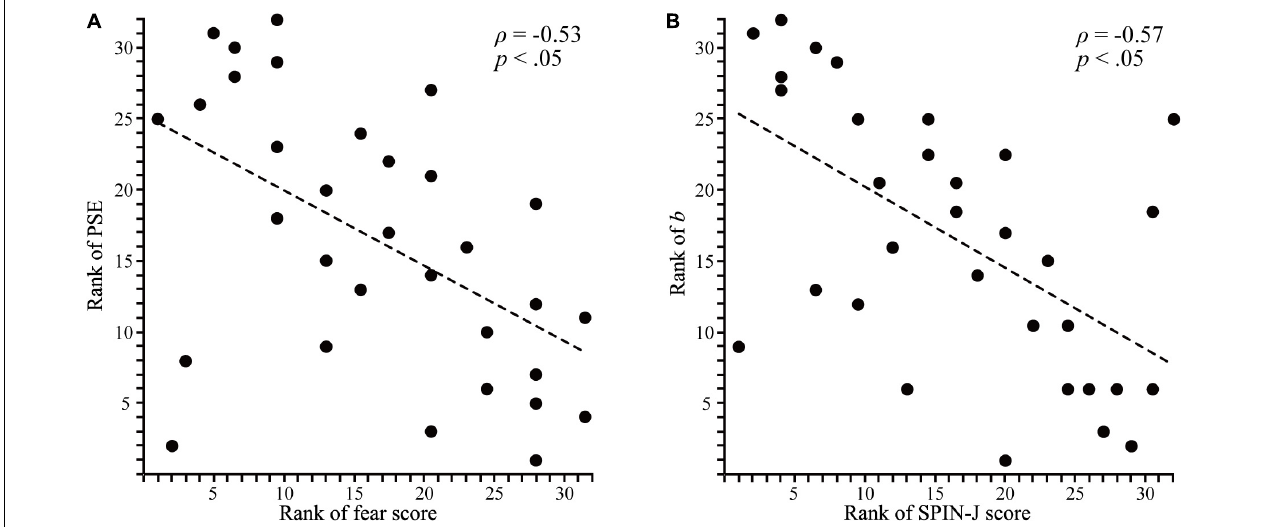
FIGURE 3 | Correlations between fear score rank and point of subjective equality rank, and SPIN-J score rank and b rank. (A) Regression line for a negative correlation between the point of subjective equality rank and fear score rank. The Spearman’s rank correlation coefficient was ρ = − 0.53 ( p < 0.05). (B) Regression line for a negative correlation between b rank and SPIN-J score rank. The Spearman’s rank correlation coefficient was ρ = − 0.57 ( p <